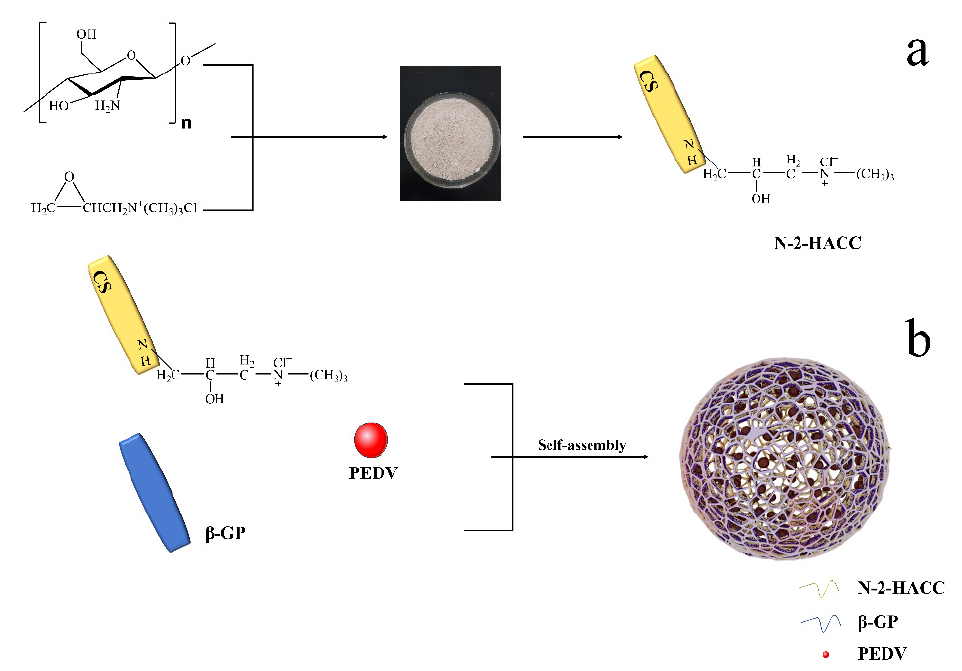
Figure 1. The schemes of synthesis of materials. ( a ) N-2-HACC; ( b ) N-2-HACC/PEDV